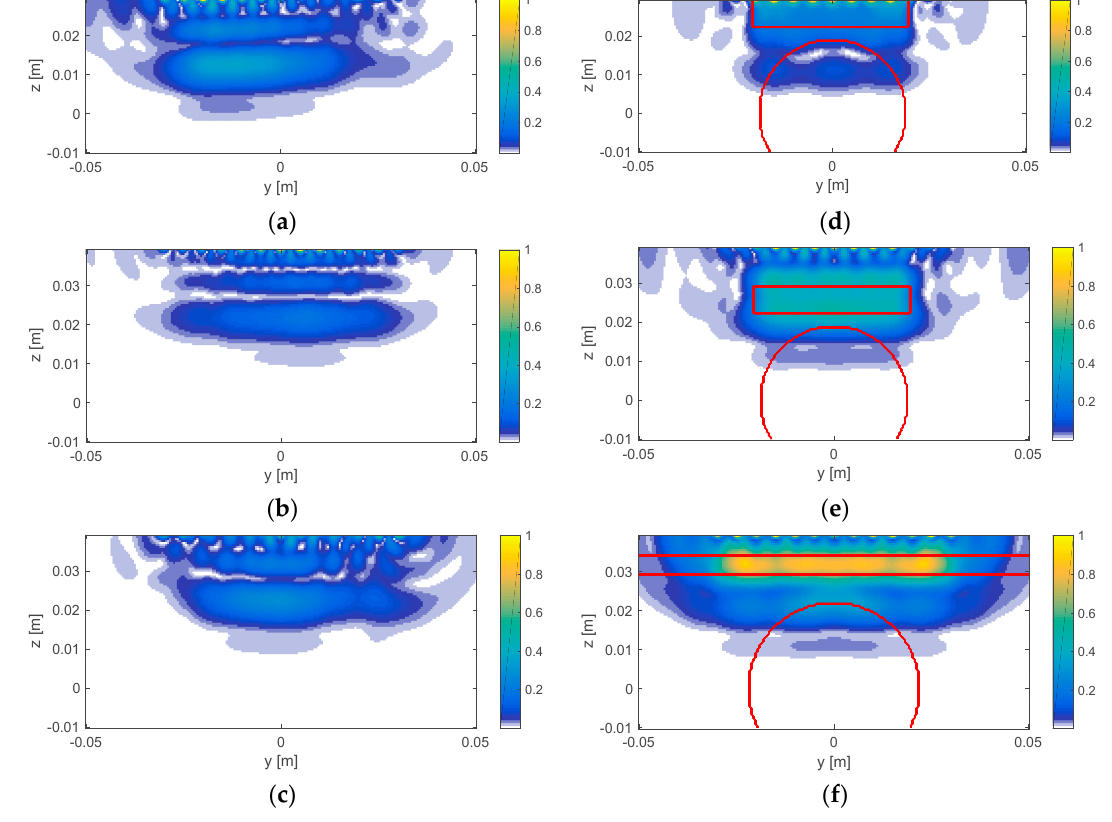
Figure 8. Comparison between tomographic results and ideal reconstructions. Each figure reports the plot of a cross-section in the yz plane of the retrieved contrast (normalized modulus). In the images, the main features (in terms of qualitative variations) of the differential contrast appear. Left side, tomographic images: ( a ) Vivaldi experiment with antenna in contact with liver sample; ( b ) Vivaldi experiment with antenna at 1 cm from sample; ( c ) Half-heart experiment with antenna at 1 cm height. Right side, ( d – f ) ideal reconstructions. Red contours denote the contour of the ideal differential contrast, as identified in Figure 7. All mps are normalized to their maximum. As such, colorbars range from 0 to 1. 0 values represent areas where no variation occurrs, while 1 values denote areas where the maximum variation is observed.